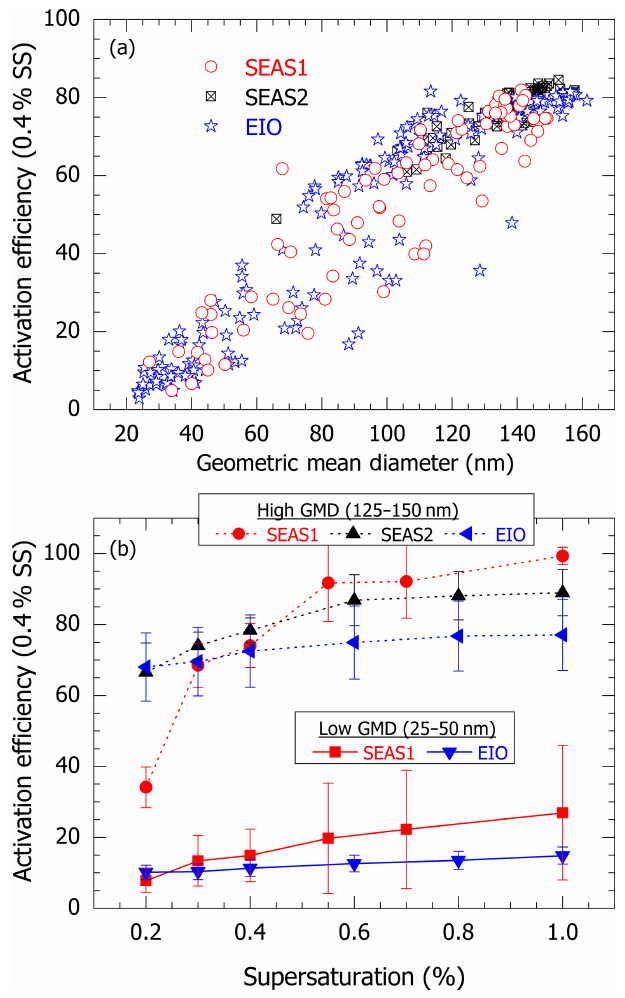
Figure 6. (a) Association of geometric mean diameter (GMD) with CCN activation efficiency at 0.4% supersaturation (SS) over SEAS1, SEAS2 and EIO during ICARB-2018. (b) Supersaturation spectra of activation efficiency for low (25–50nm) and high (125– 150nm) GMD values during SEAS1 and EIO. All the size distri- bution measurements during SEAS2 have a GMD above 50nm. Vertical bars on the symbol indicate the standard deviation of the